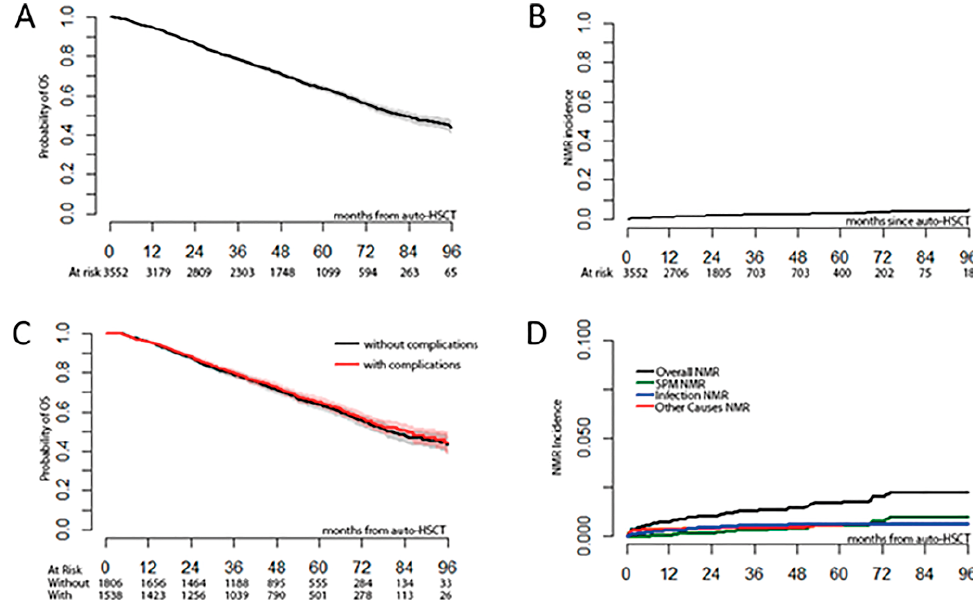
Figure 2. Survival and mortality outcomes after autologous stem cell transplantation. ( A ) Probability of overall survival. ( B ) Cumulative incidence of non-relapse mortality. ( C ) Overall survival of patients with and without complications. ( D ) Cumulative incidence of non-relapse mortality by its different causes.